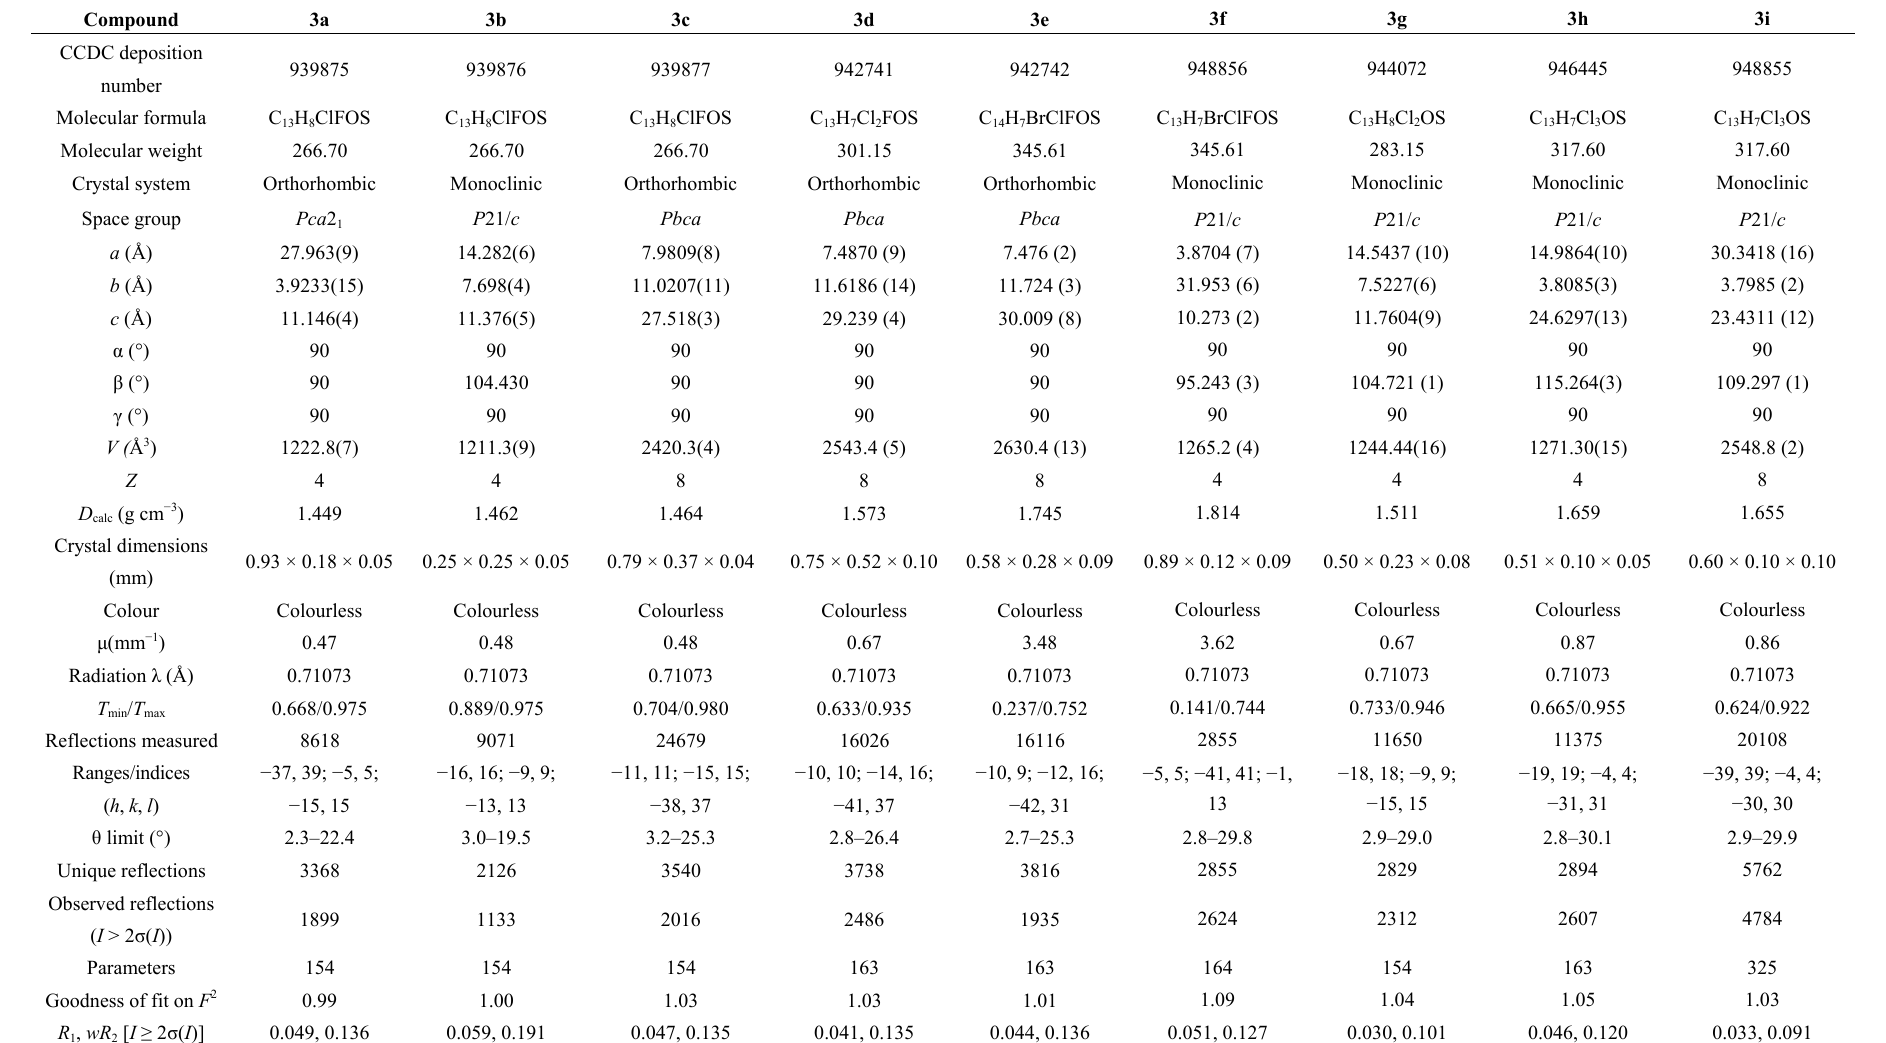
Table 1. Crystal data and parameters for structure refinement of 3a to 3i